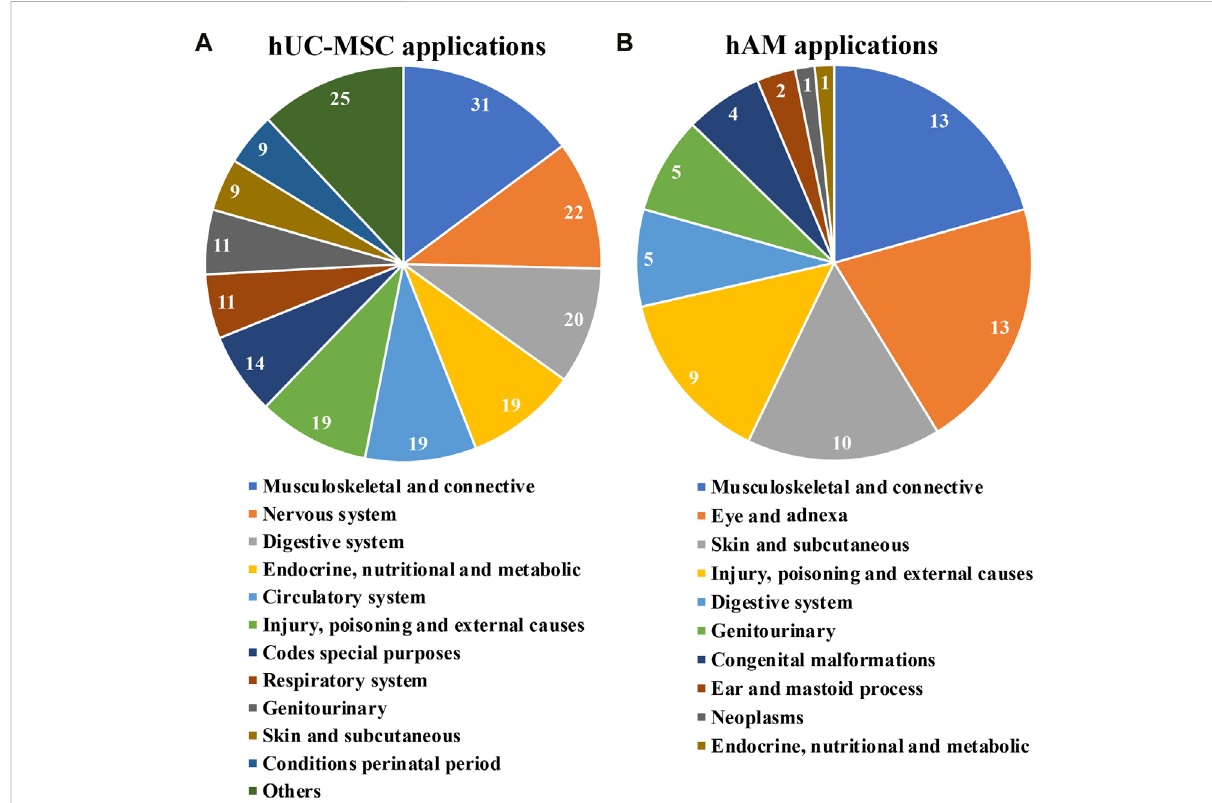
FIGURE 5 Applications for hUC-MSC (A) and for hAM (B) ; grouping according to medical fi elds ICD-10 classi fi cation of clinical trials implementing hUC- MSC and for hAM